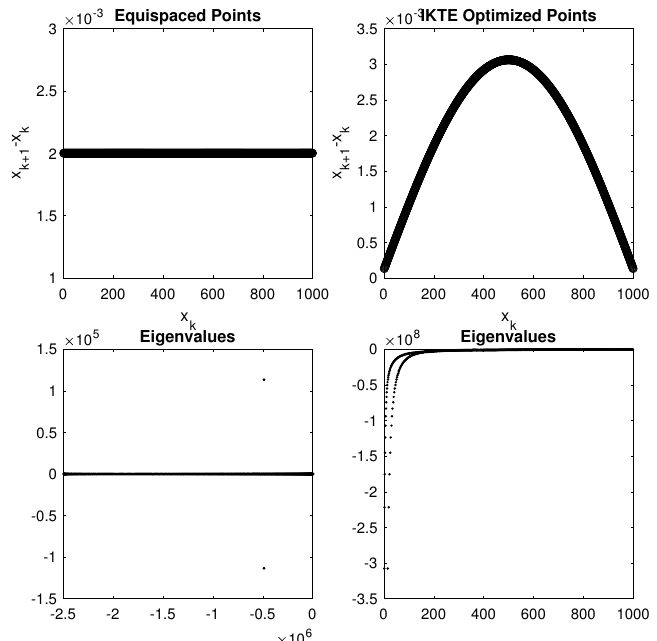
Figure 6. Equispaced points, IKTE optimized points, and their eigenvalues for a 37-point stencil with polynomials up to degree p = 15. The equispaced points produce complex eigenvalues, while the IKTE optimized points produce purely real eigenvalues.